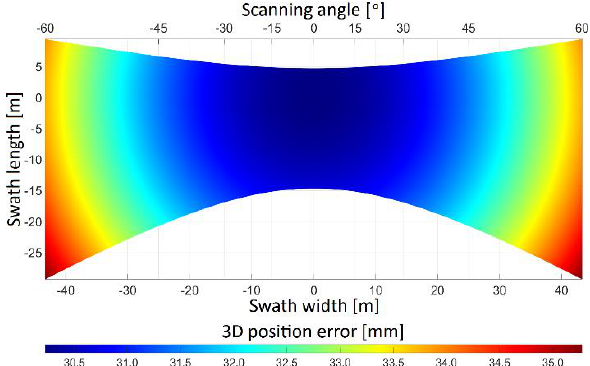
Figure 6. UAV position differences calculated between forward and reverse EKF